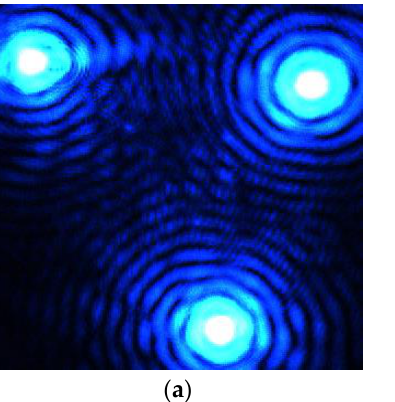
Figure 10. ( a – c ) Three determined single circular patterns separated by using the proposed method; ( d ) the mixed fringe pattern of three ( a – c ) separated signals.